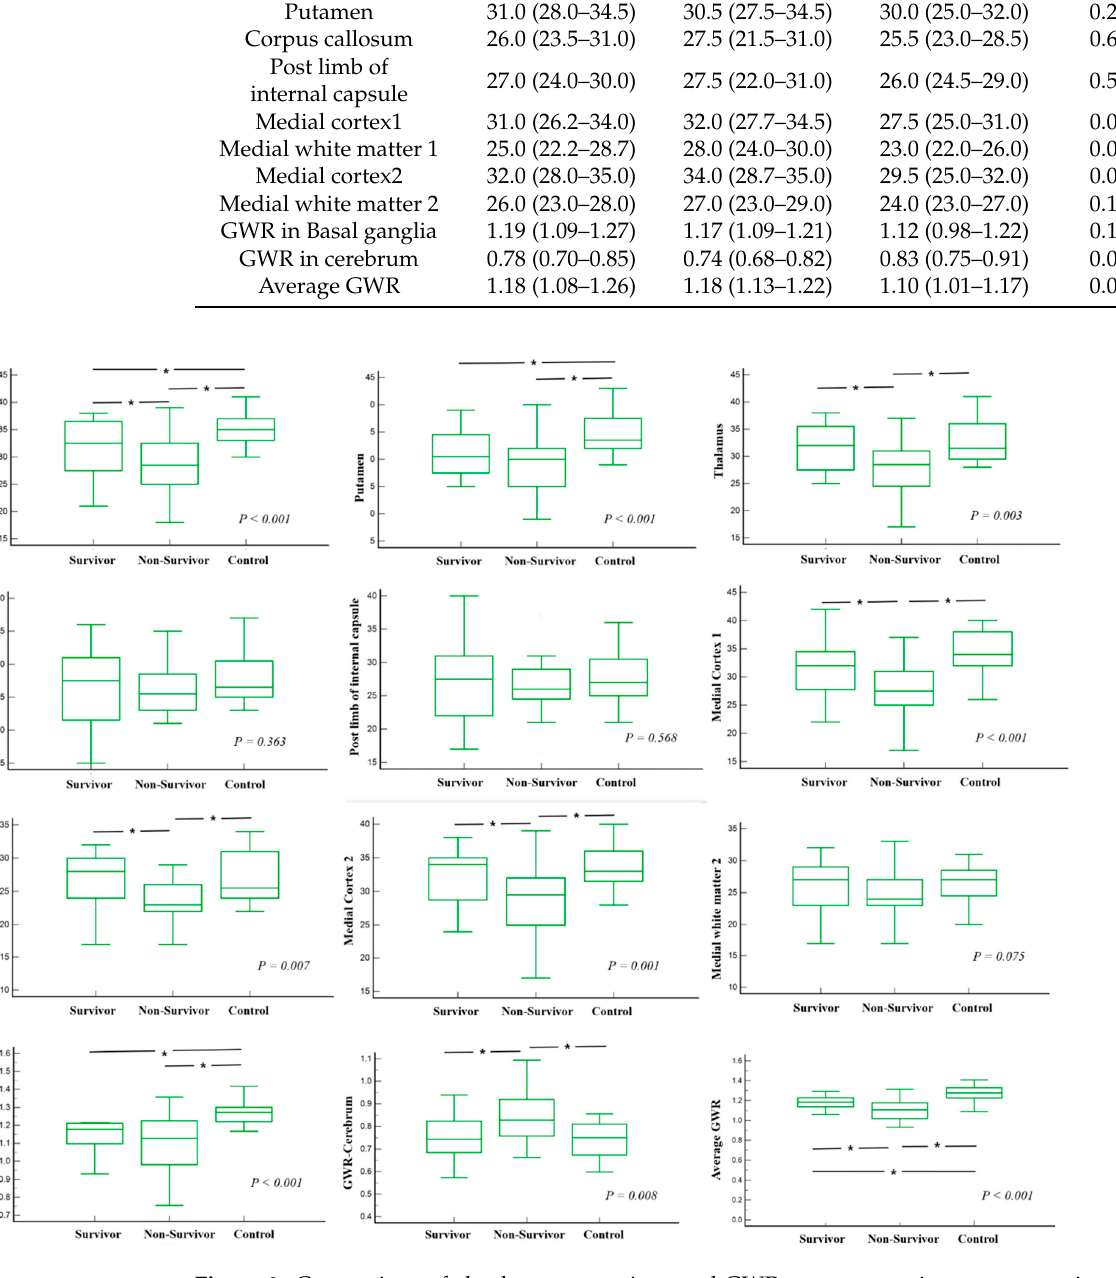
Figure 3. Comparison of absolute attenuations and GWRs among survivors, non-survivors, and healthy controls. * p <